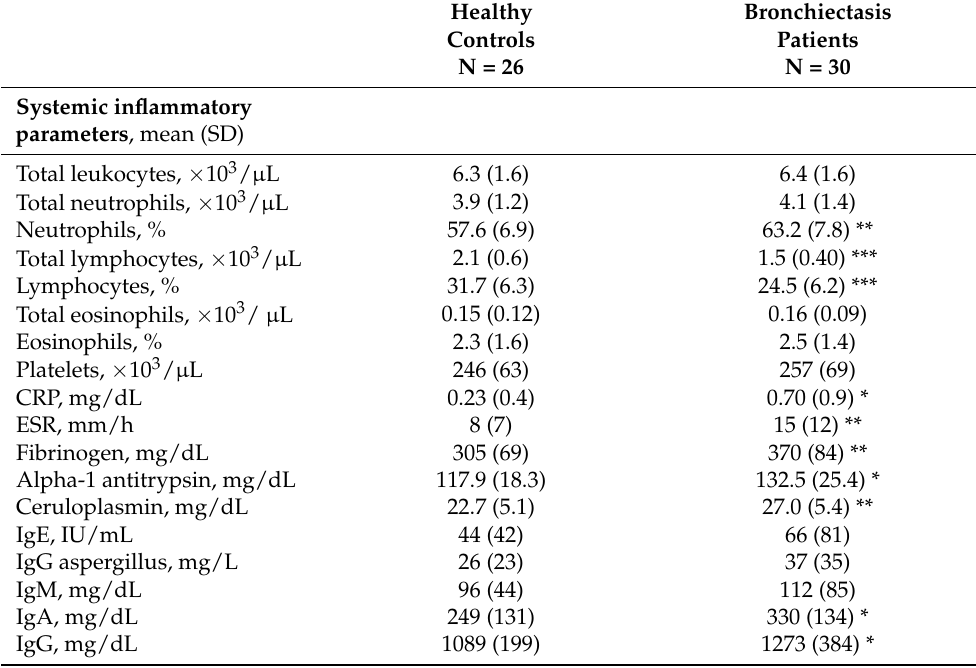
Table 5. Systemic inflammatory parameters in bronchiectasis patients and healthy